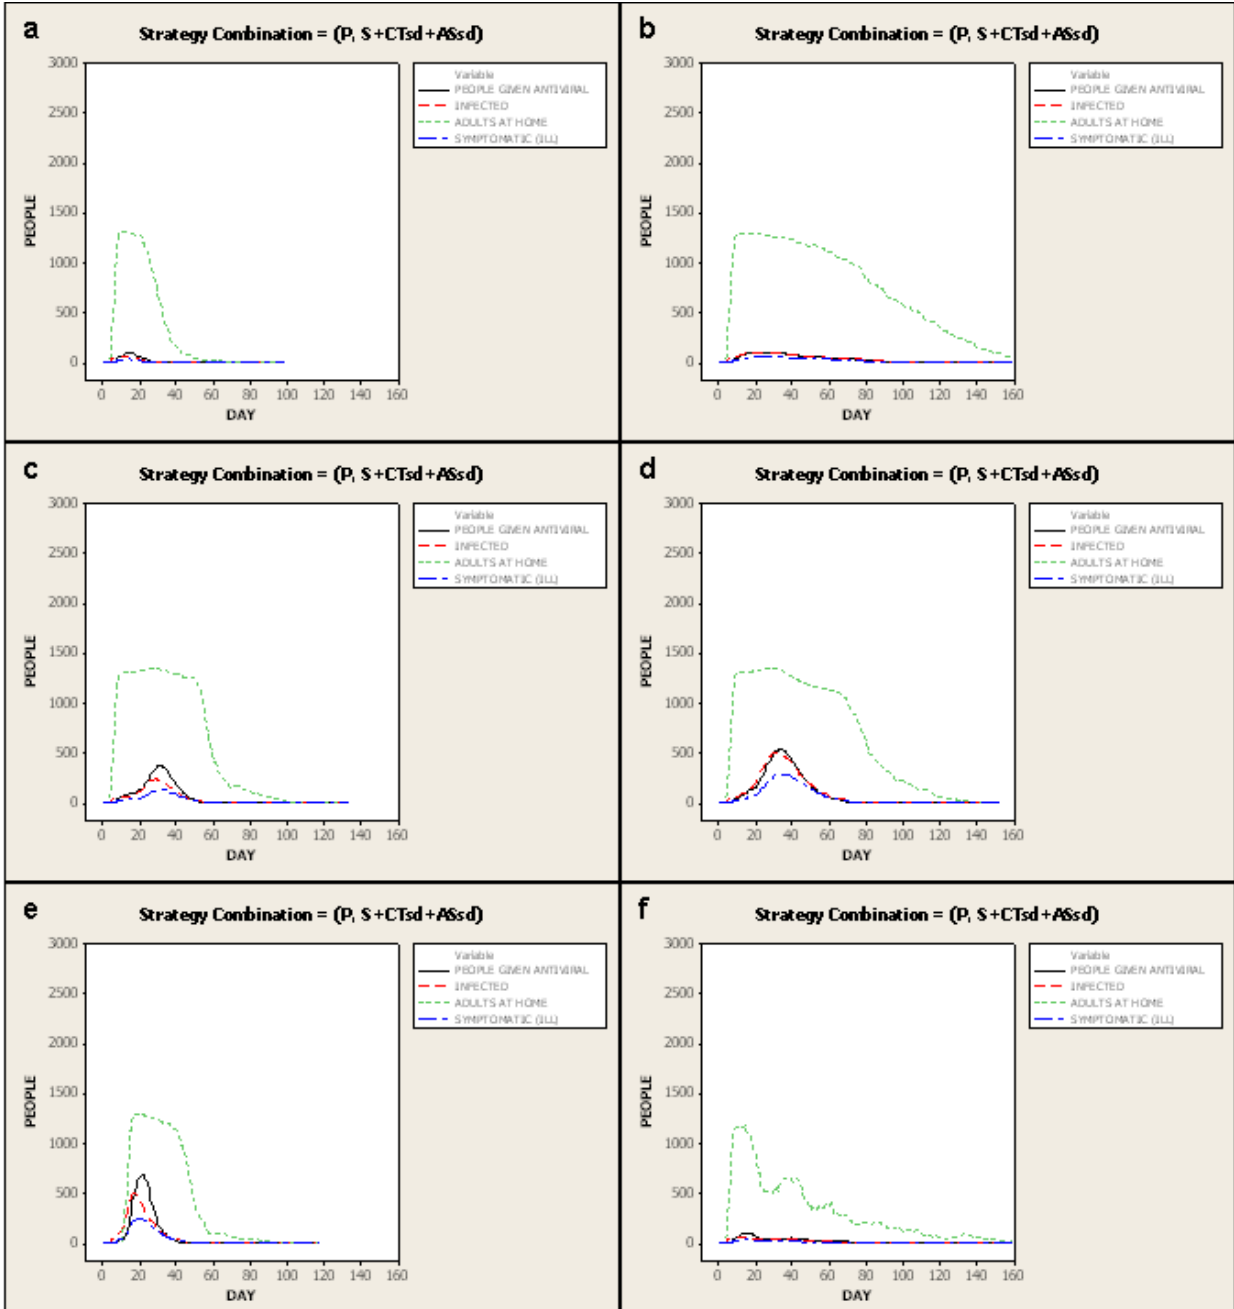
Figure 5. Epidemic effects with perturbed parameter assumptions. Plots of I F 1.5 epidemics (Ferguson-like disease manifestation) with best strategy applied showing effects of reduced compliance, local-only mitigation, reduced compliance and local-only mitigation, delayed implementation threshold to 100 cases, and relaxed (3-case/7day) rescinding threshold. Plots are averages of all 100 simulations. Comparisons are to the best strategy plot. a—the best strategy found in these simulations (P + S + CTsd + ASsd). b—best strategy applied at 60% compliance. Note the extended duration of epidemic effects ( . 160 days), length of time antivirals are required, and greatly increased requirements for adult days at home. c—best strategy applied at 90% compliance with local-only mitigation. Note the increase in use of antivirals, extended epidemic effects and increase in adult days at home. d—best strategy applied at 60% compliance with local-only mitigation. Note the higher peaks in numbers of infected and symptomatic near day 40, the increased use and longer duration of need for antivirals and the longer duration of epidemic effects to nearly 160 days. e—best strategy applied with delayed implementation (when 100 cases have occurred). Note the high, early peak of cases and accompanying need for antivirals until the strategy controls the epidemic at day 120. f—best strategy applied with the 3-case/7 day rescinding threshold. Note the extended duration of the epidemic and the erratic downslope of adult days at home as the mitigation strategy cycles off when the rescinding threshold is met and on again when 10 cases occur (the implementation threshold).